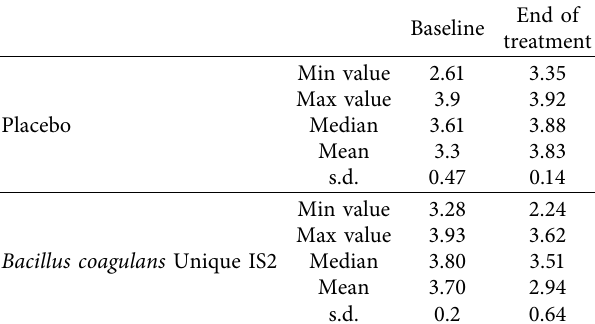
Table 4: Salivary lactobacilli scores at baseline and